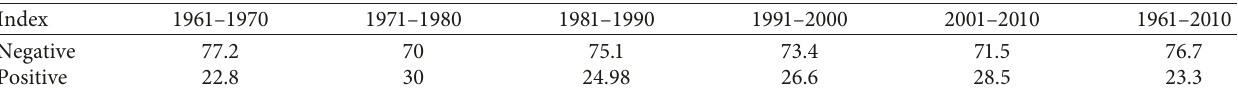
Table 3: The percentage of country’s areas (studied stations) influenced by positive and negative anomalies of thunderstorms in different